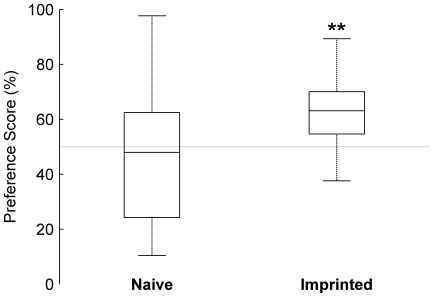
Behaviour during presentation of audiovisual stimuli.Preference scores for audiovisual imprinting stimulus. Box plots indicate median preference scores (center bar), upper and lower quartiles (box) and whiskers represent the range. (**) Comparison of individual medians revealed that the preferences for the audiovisual imprinting stimulus of imprinted (n = 8) but not naïve chicks (n = 9) were greater than chance (50%, sign test: naïve chicks, P>0.5; imprinted, P = 0.008).